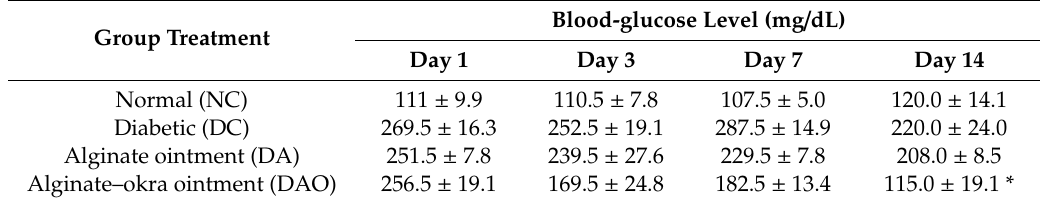
Table 2. Total blood glucose of mice on Days 1, 3, 7 and 14 after treatment. Group